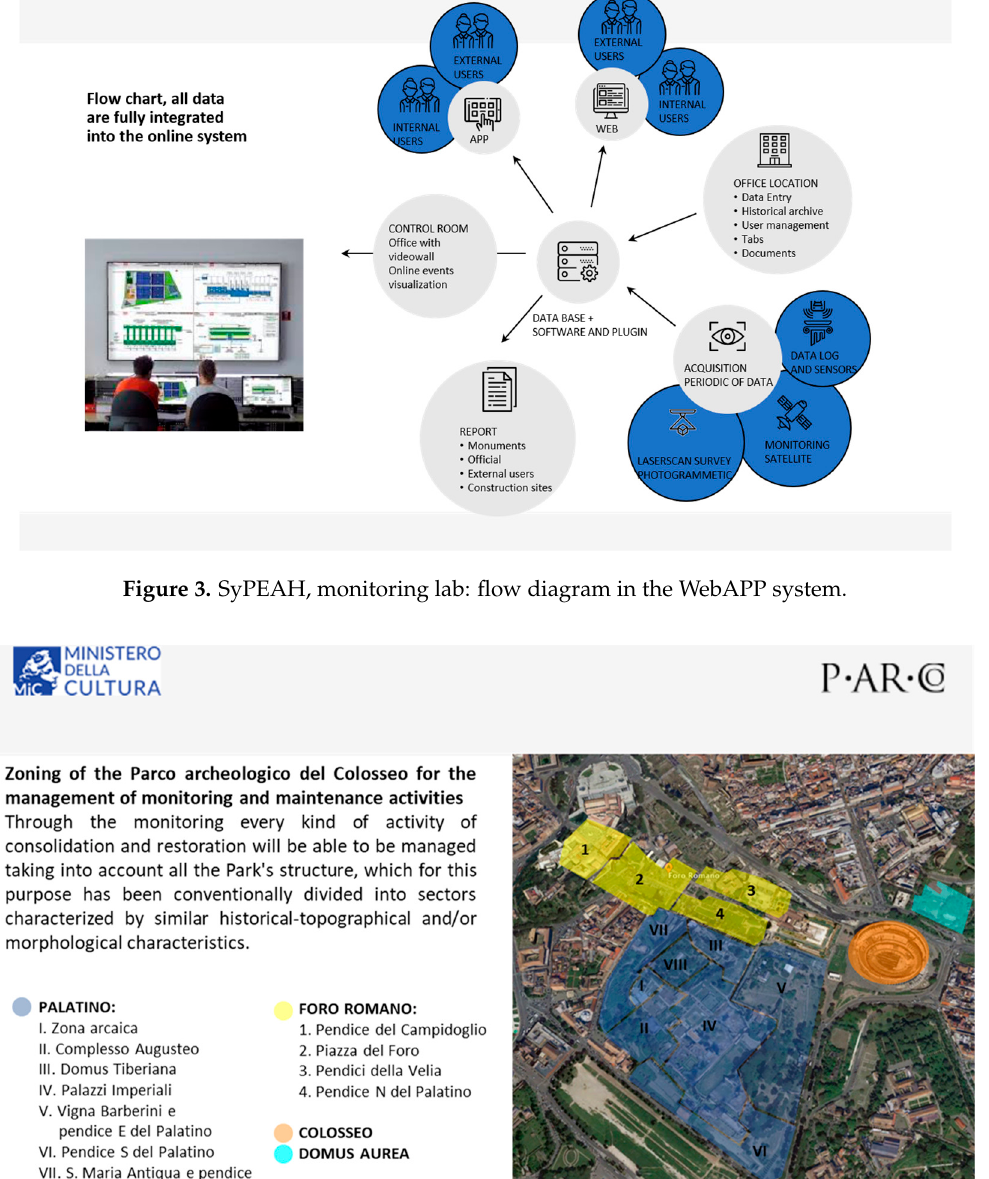
Figure 4. Zoning of the archaeological area for the management of monitoring and maintenance